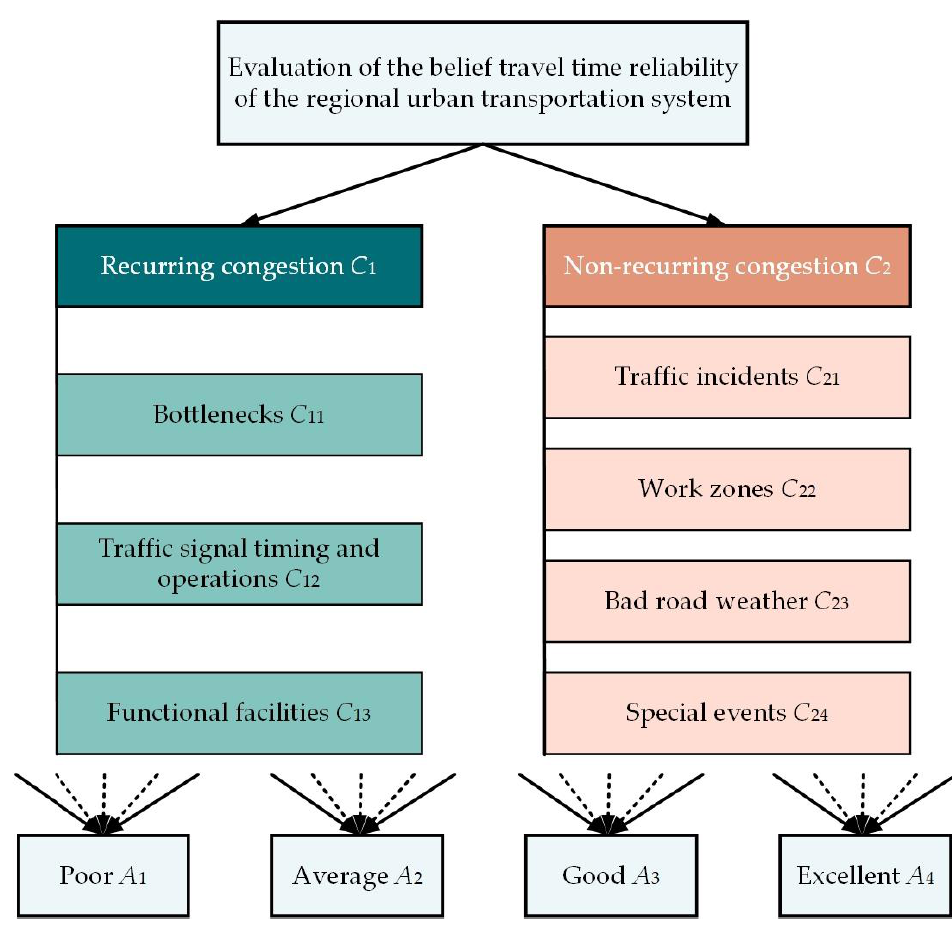
Figure 3. The hierarchical structure of the problem.